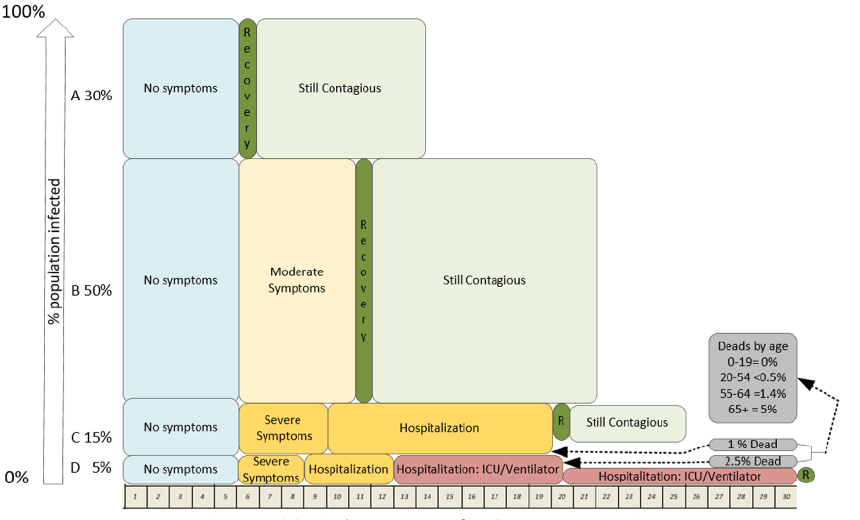
Figure 1. Typical progress of a COVID-19